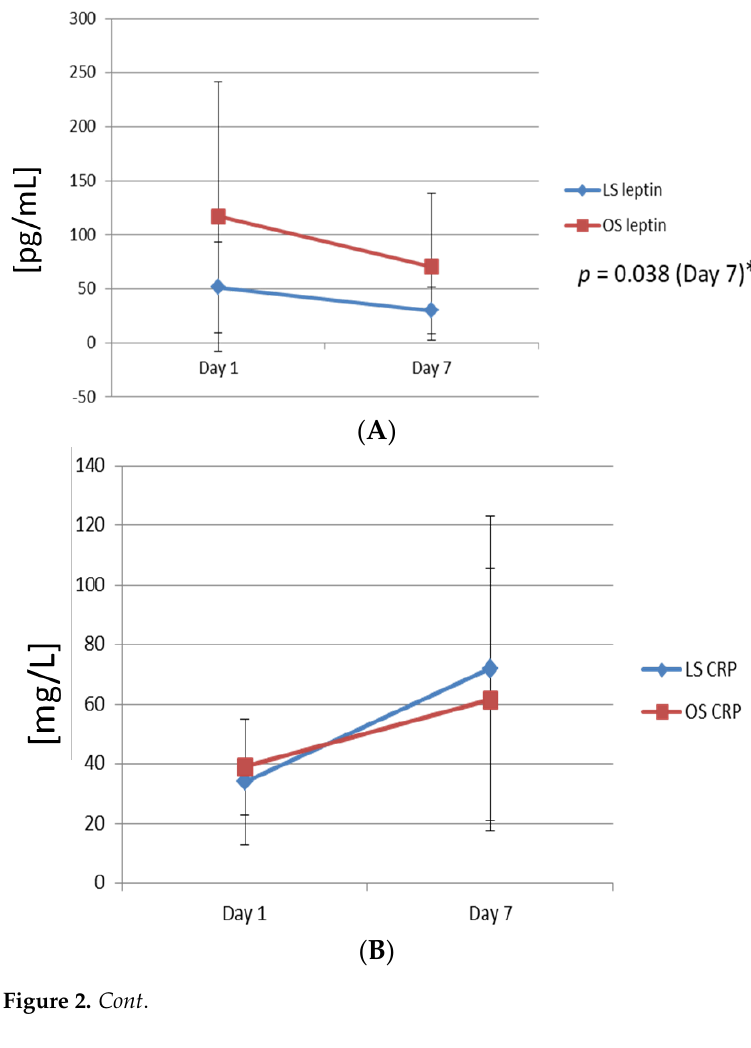
Figure 1. Postoperative dynamics of serum leptin, CRP, haemoglobin, and albumin between groups. ( A ) Postoperative dynamics of serum leptin concentrations. ( B ) Postoperative dynamics of serum CRP. ( C ) Postoperative dynamics of serum haemoglobin. ( D ) Postoperative dynamics of serum al- bumin. LS: laparoscopic surgery; OS: open surgery.